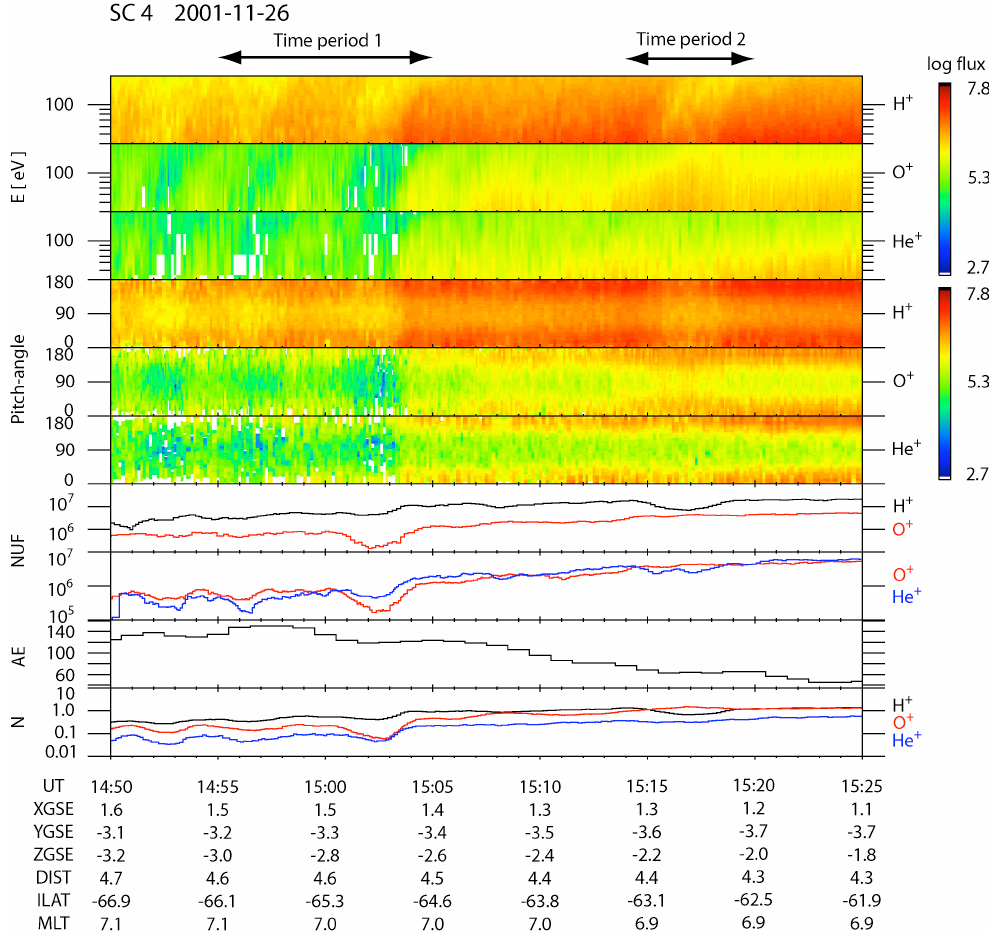
Figure 5: Energy-time spectrograms and differential fluxes in [(cm 2 s sr) -1 ], pitch-angle Fig. 5. Energy-time spectrograms, pitch-angle distributions [(cm 2 ssrkeV) − 1 ], net upgoing fluxes (NUF) in [cm − 2 s − 1 ], AE in [nT] and density plot in [cm − 3 ] in the low energy range of 40eV to 200eV for H + , O + and He + during the period from 14:50UT through 15:25UT, distributions, net upgoing fluxes (NUF) in [cm -2 s -1 ], AE in [nT] and density plot in [cm -3 ] in on 26 November the low energy range of 40 eV to 200 eV for H + , O + and He + during the period from 14:50 UT through 15:25 UT, on November 26, 2001.